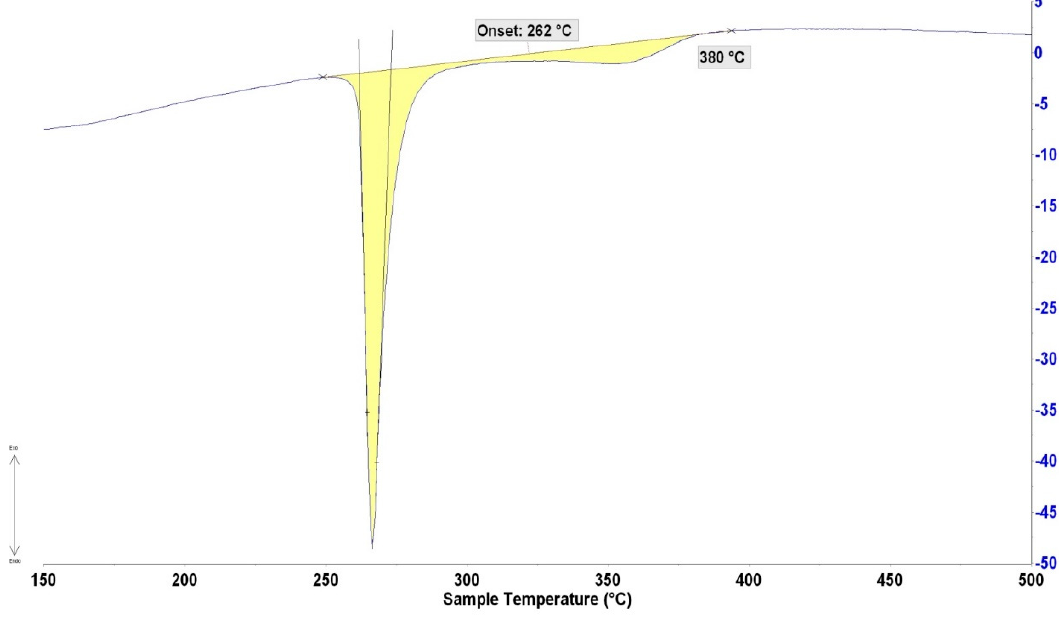
Figure 6. DTA analysis of Bi11Ag1Mg solder, the heating rate of 5 °C/min.